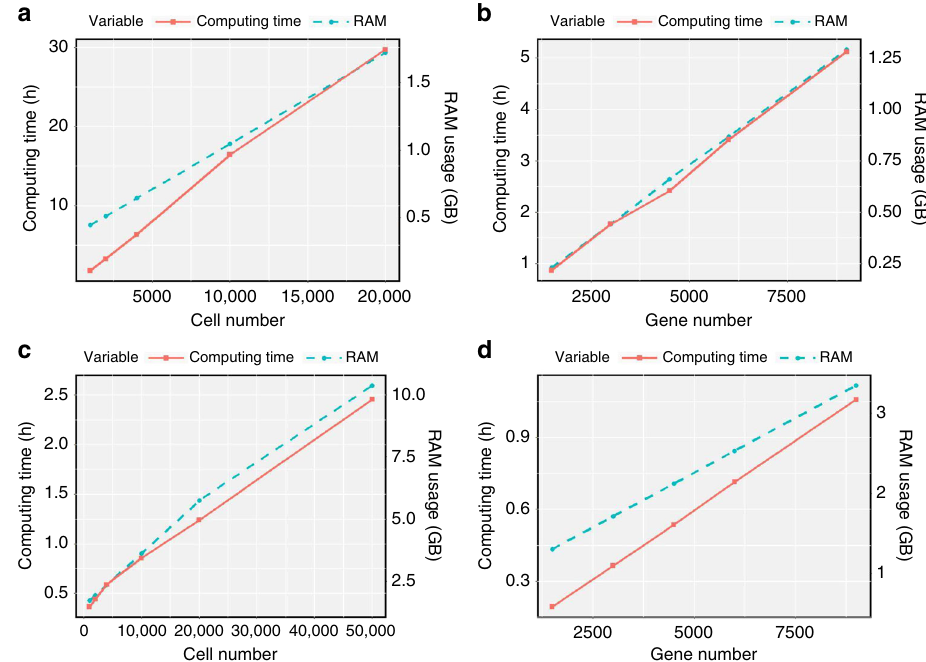
Fig. 9 The trend of running time and RAM usage with respect to gene and cell numbers. Running time and RAM usage for a , b the central processing unit (CPU) parallel version of BUSseq on eight cores of Dual Intel Xeon E5-2650 v2 2.60 GHz processors and c , d the graphics processing unit (GPU) parallel version of BUSseq on a single core of an Intel Xeon Gold 6132 processor and one NVIDIA Tesla P100 GPU. a When G = 3000 and n s = 1000, N varies from 1000 to 20,000. b When N = 1000 and n s = 1000, G varies from 1500 to 9000. c When G = 3000, N varies from 1000 to 50,000. d When N = 1000, G varies from 1500 to